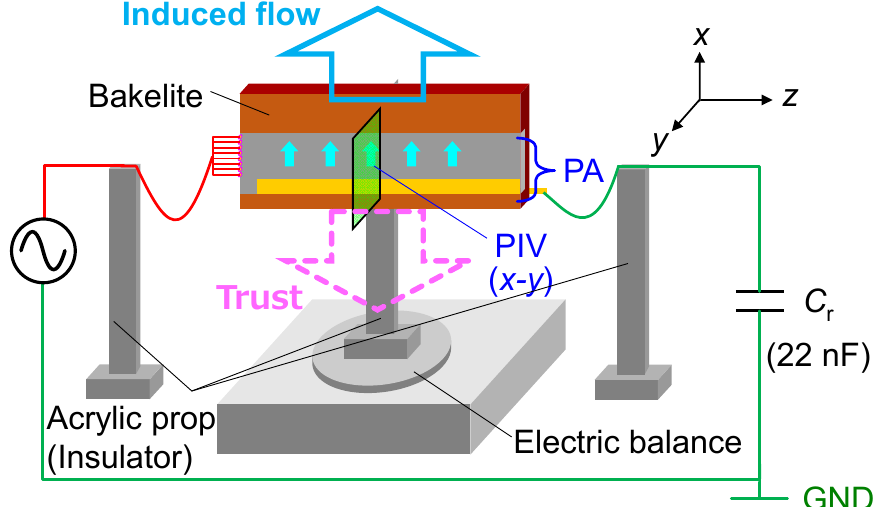
Figure 3. Experimental setup for thrust measurement. The green area represents the region of flow visualization for PIV analysis.